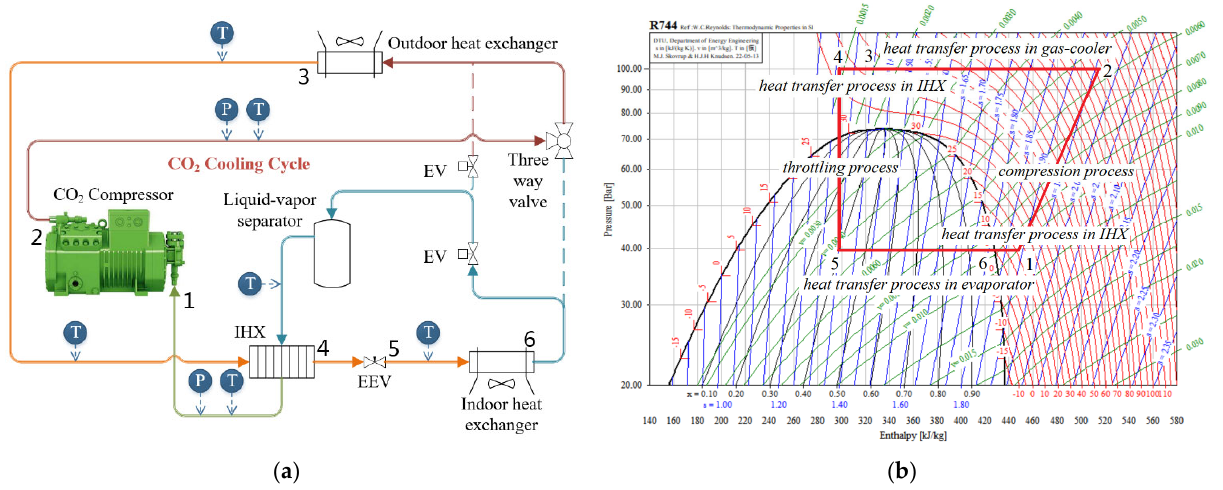
Figure 1. ( a ) The schematic of the transcritical CO 2 -based bus air conditioning/heat pump system. ( b ) The P-h diagram of the transcritical CO 2 -based bus air conditioning/heat pump system under cooling conditions.